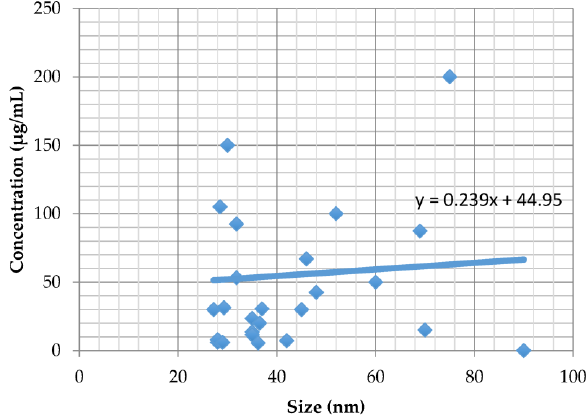
Figure 1. The correlation between the average size of the plant-mediated syntheses of metallic nanoparticles and cytotoxicity at 24 h of exposure. Plant metallic nanoparticles; Trendline.